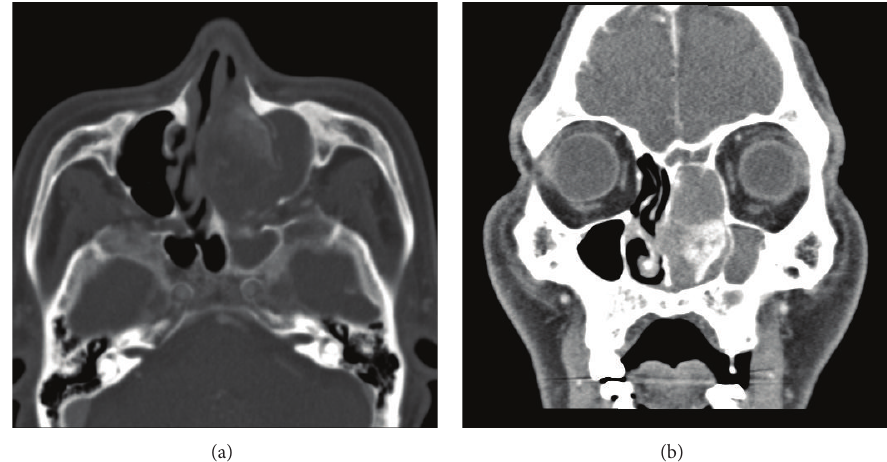
Figure 2: Preoperative computed tomography images showing a mass in the left middle turbinate as well as total opacification in all the sinuses: (a) axial view of the bone window; (b) coronal view of the mediastinum